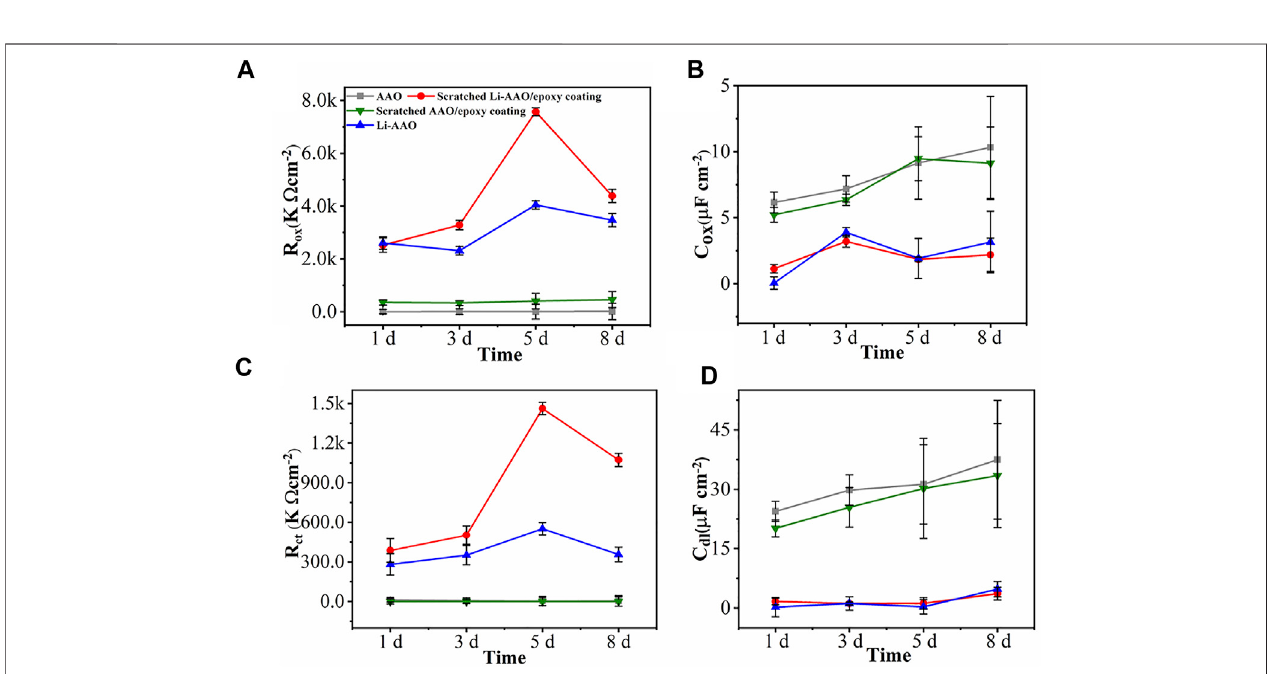
FIGURE 4 | Evolution of the (A) oxide resistance (R oxide ), (B) oxide capacitance (C oxide ), (C) charge transfer resistance (R ct ), and (D) double-layer capacitance (C dl ) of the AAO substrate, Li-AAO substrate, scratched AAO/epoxy coating, and scratched Li-AAO/epoxy coating.